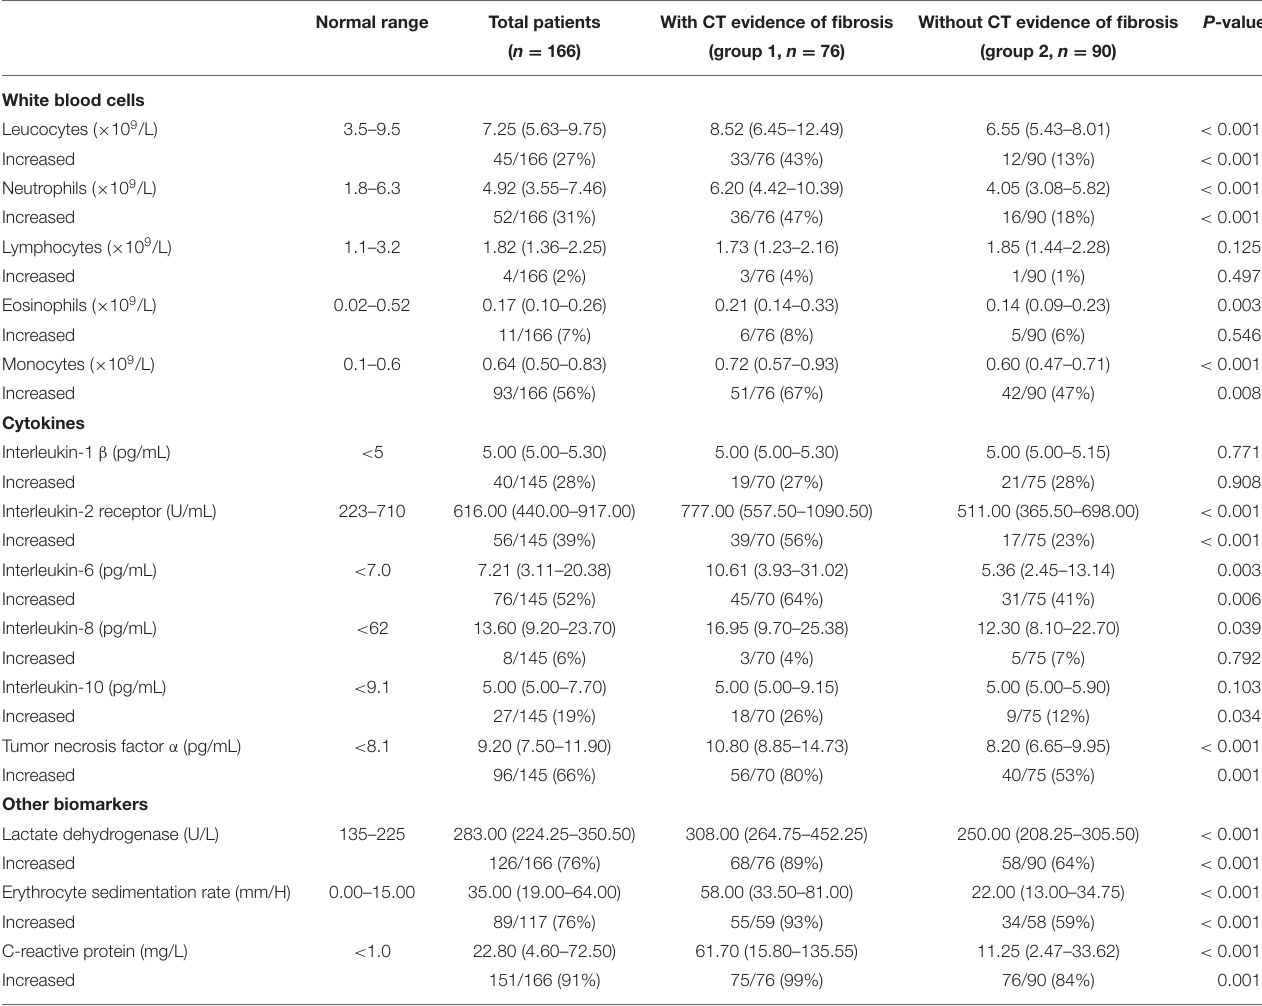
TABLE 3 | Peak laboratory data of patients with COVID-19. Normal range Total patients With CT evidence of fibrosis Without CT evidence of fibrosis P